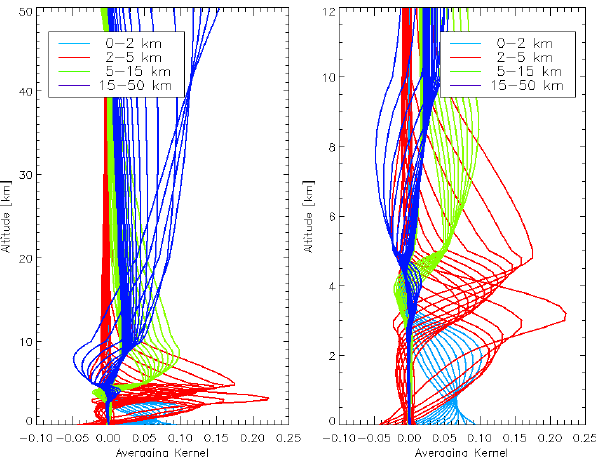
Figure 3. Example of averaging kernel vs. altitude. The sim- ulation refers to a convolved spectrum of spectral resolution (cid:49)ν = 0.01cm − 1 and FWHM = 0.05cm − 1 with a solar zenith an- gle SZA = 45 ◦ and an instrument viewing angle of 30 ◦ off-nadir. The AK are color-coded for different altitude ranges. On the right, a zoom between 0 and 12km is